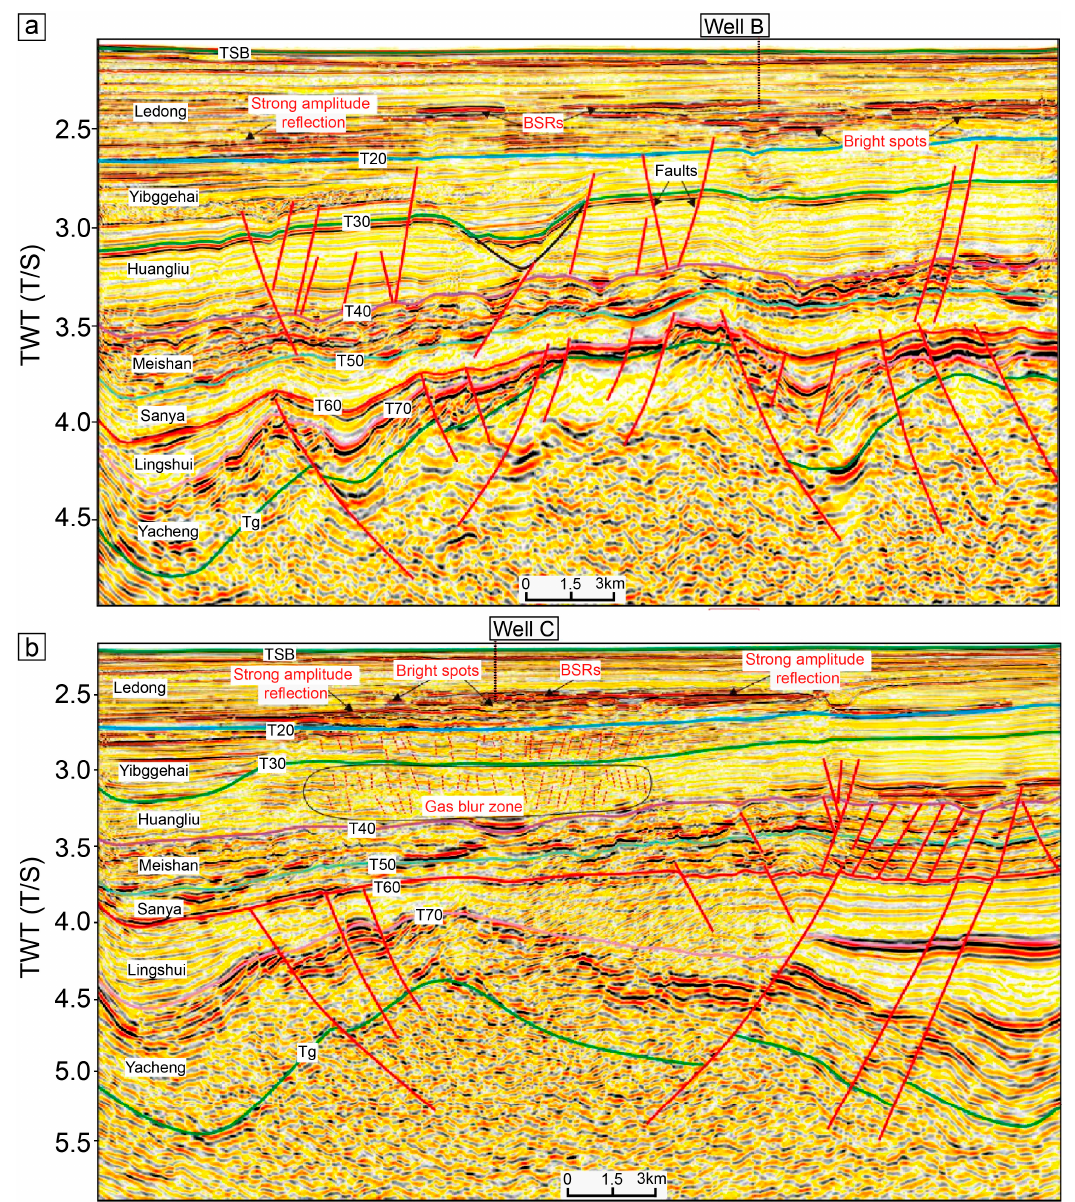
Figure 3. Seismic pro fi les of ( a ) SP1 and ( b ) SP2 in the QDNB (modi fi ed from Reference [46]).